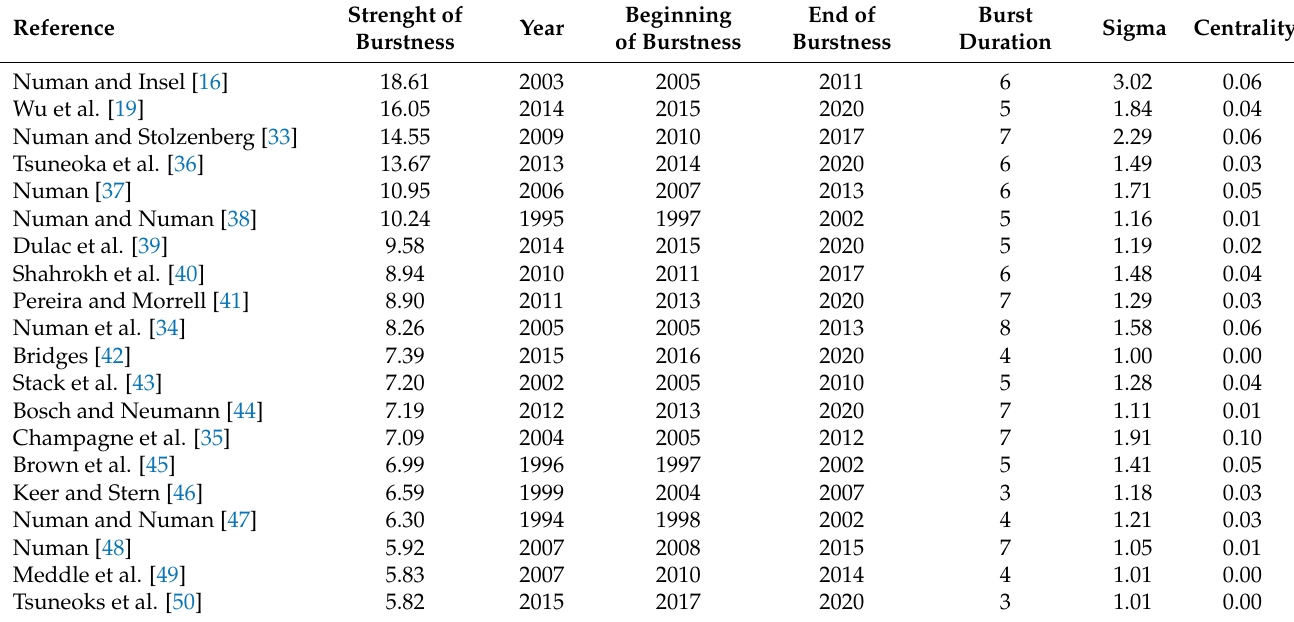
Table 2. Description of the identifying characteristics of the 20 publications with high citation burstness metrics generated in the